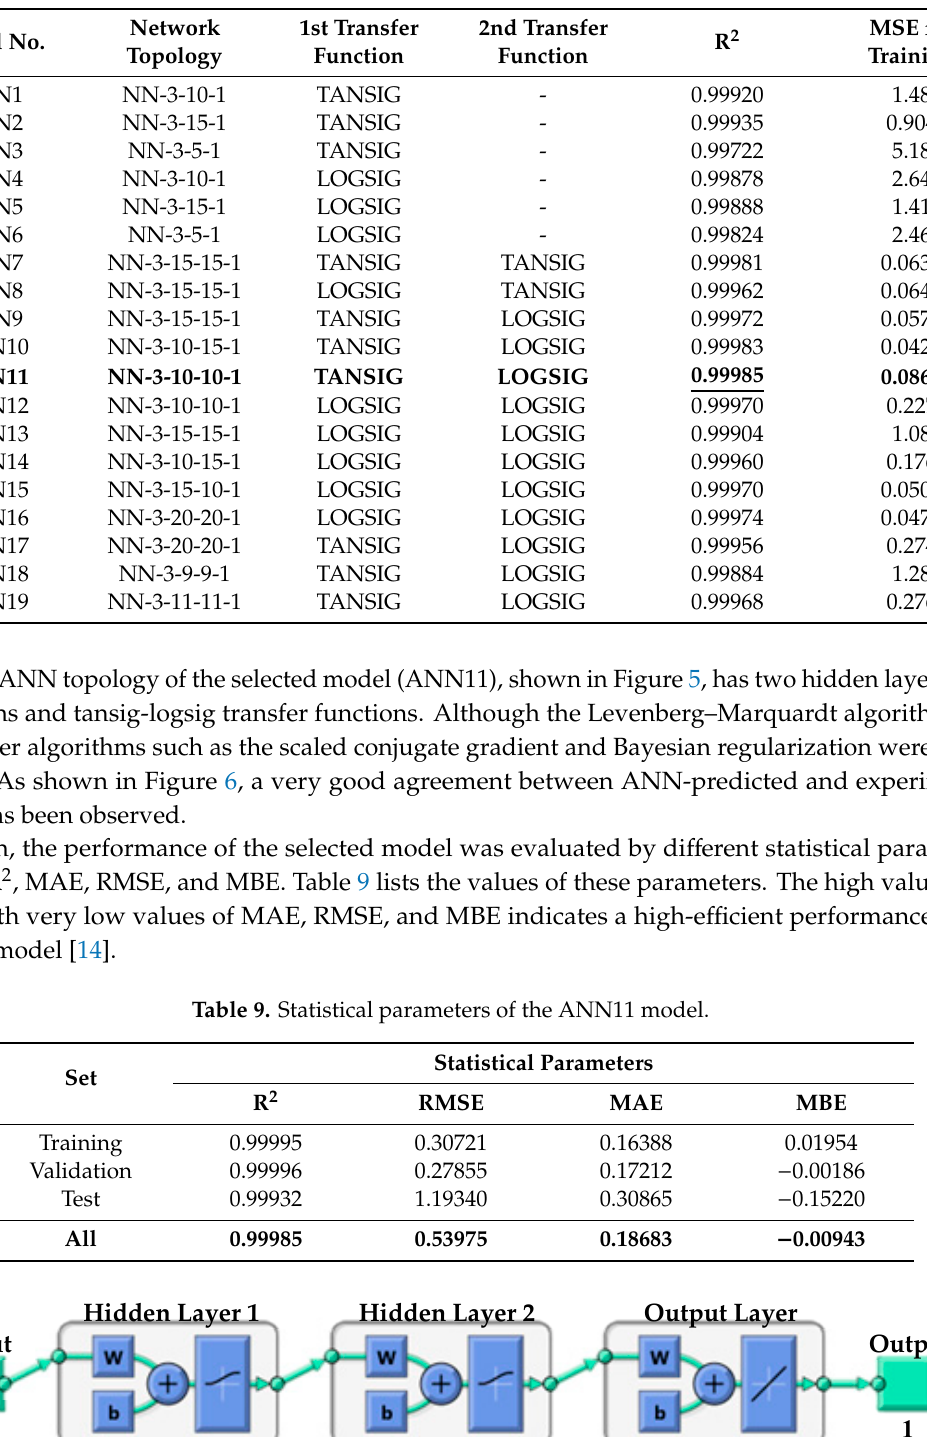
Table 8. Prediction performance of di ff erent artificial neural network (ANN)-architecture.